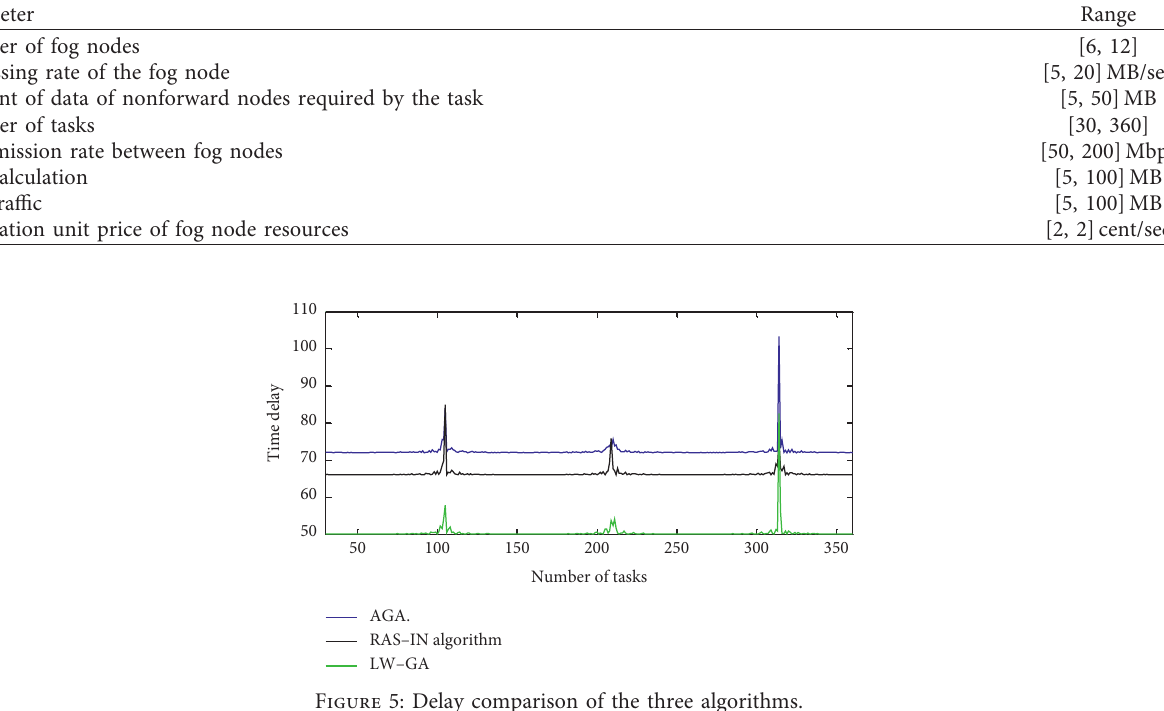
Table 1: Simulation parameter settings.